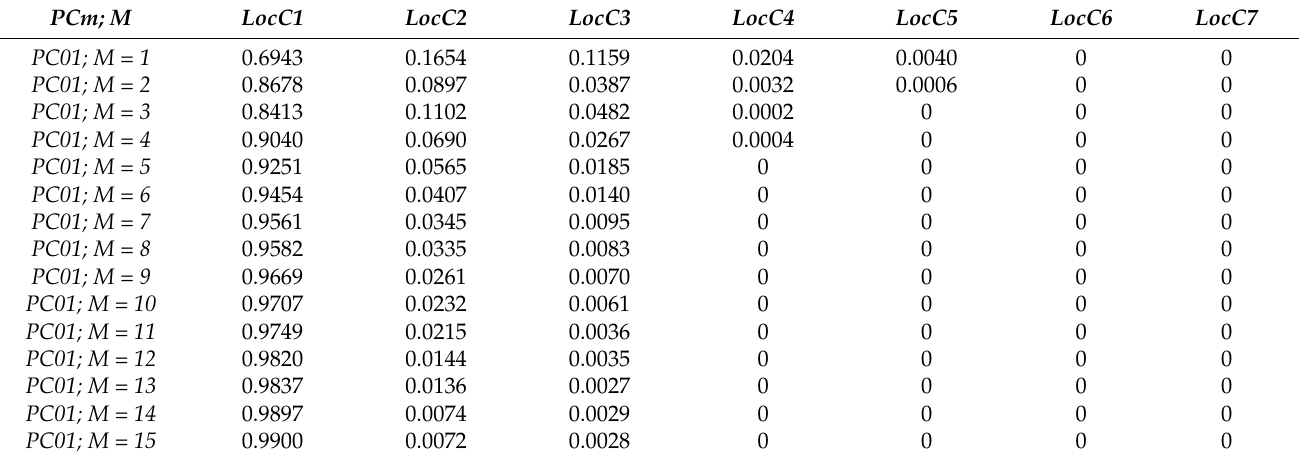
Table 6. Probability of designating a LocCn locator node as the closest one to the wristband placed at PC01 location with different window widths M .